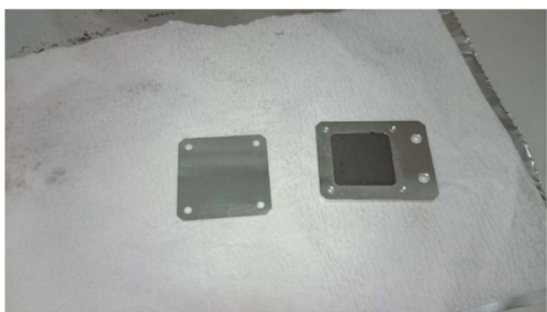
Figure 3. Sample container filled with the DNP powder.